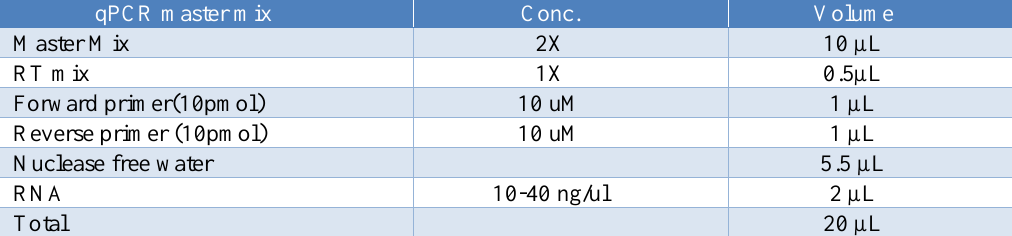
Table,2: The quantitative PCR (qPCR) master mix